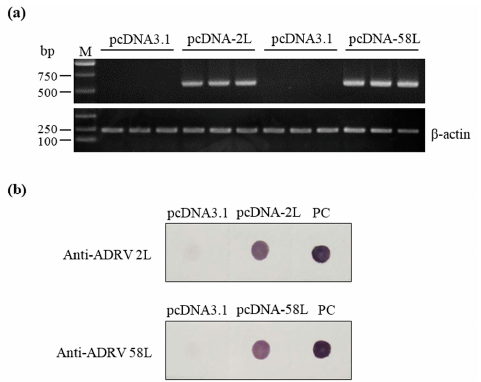
Figure 2. Expression of the 2L and 58L proteins in vaccinated Chinese giant salamanders. ( a ) RT-PCR analysis of the 2L and 58L gene transcriptions in muscle tissues from vaccinated Chinese giant salamanders at seven days post-vaccination ( n = 3). The β -actin gene was used as an internal control. ( b ) Immunodot blot analysis of the expressed 2L and 58L proteins in muscle tissues from vaccinated Chinese giant salamanders at seven days post-vaccination. Andrias davidianus ranavirus (ADRV) suspension from infected EPC cell cultures was used for a positive control (PC).